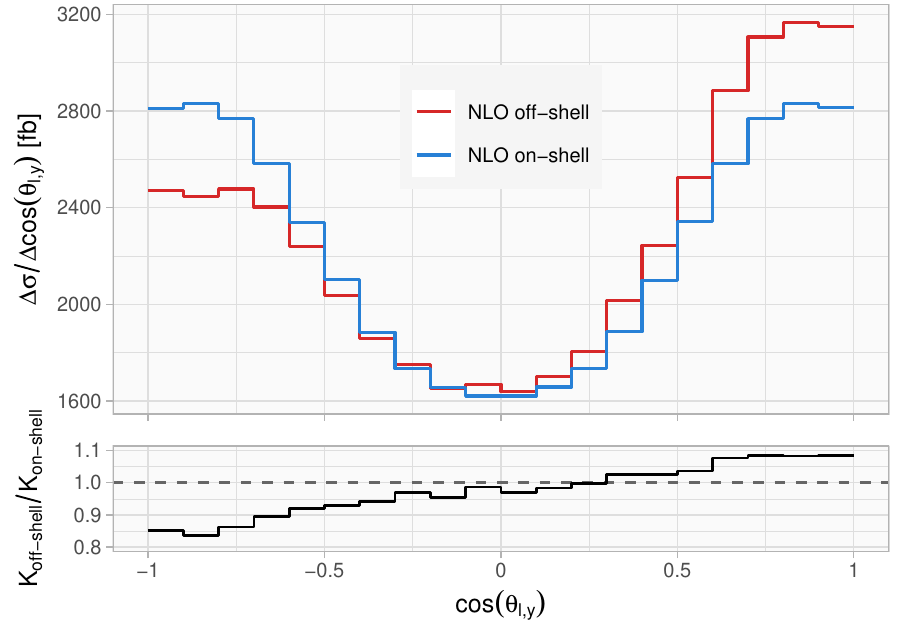
Figure 15. Distribution of cos (cid:18) l;y at NLO in the on-shell approximation and for an o(cid:11)-shell top quark. The lower panel shows the ratio of the o(cid:11)-shell and on-shell K -factors. Note the range of the y -axis, which does not start at zero.